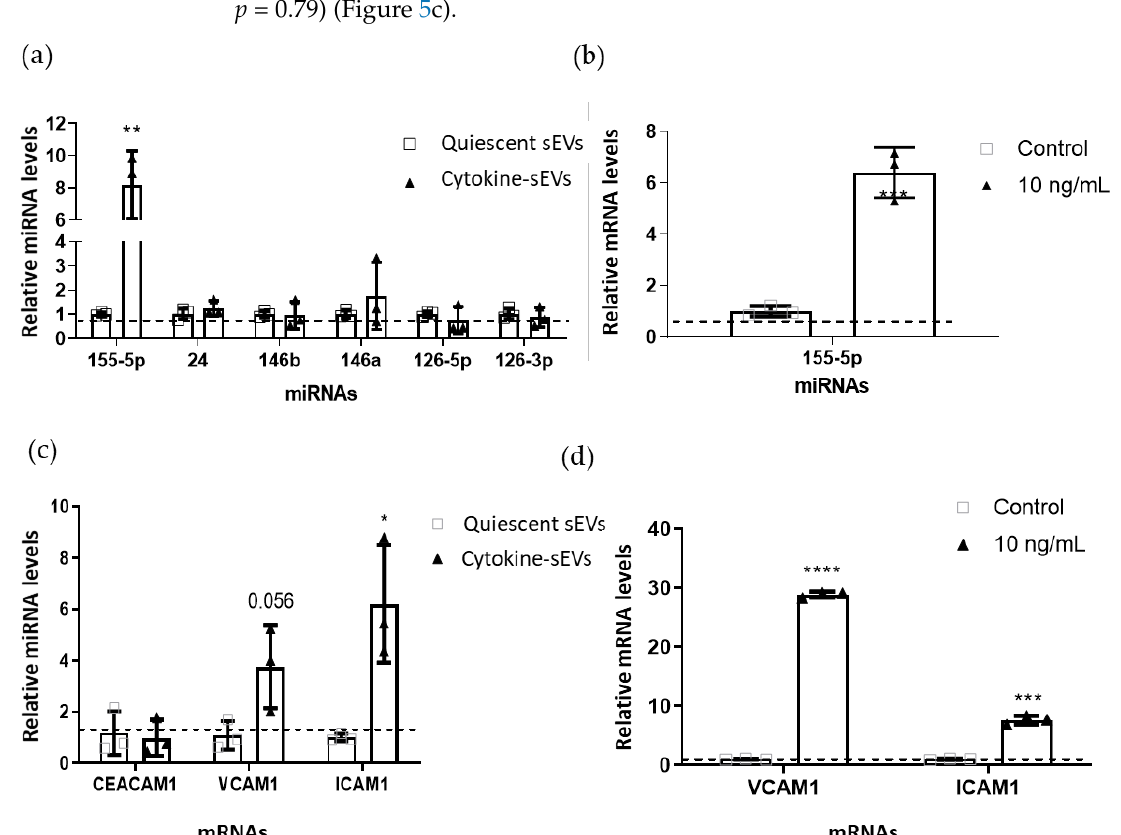
Figure 5. Characterisation of inflammation-related miRNAs and mRNAs in sEV and secreting hCMEC/D3 cells. ( a ) Quantification of levels of miRNA-155-5p, miRNA-146a, miRNA-146b, miRNA-126-5p, miRNA-126-3p and miRNA-24 in cytokine-sEVs and quiescent sEVs. ( b ) Levels of miRNA-155-5p in naïve hCMEC/D3 cells and those treated with 10-ng/mL TNFα and IFNy. ( c ). mRNA levels of vascular cell adhesion molecule ( VCAM1 ), intercellular adhesion molecule ( ICAM1 ) and carcinoembryonic antigen-related cell adhesion molecule 1 ( CEACAM1 ) in cytokine-sEVs and quiescent sEVs. ( d ) Levels of VCAM1 and ICAM1 mRNA in naïve hCMEC/D3 cells and those treated with 10-ng/mL TNF α and IFNy. Data are shown as the mean ± SEM ( n = 3). The means were compared by unpaired two-tailed t -tests, * p < 0.05, ** p < 0.01, *** p < 0.001, **** p < 0.0001 compared to quiescent sEV